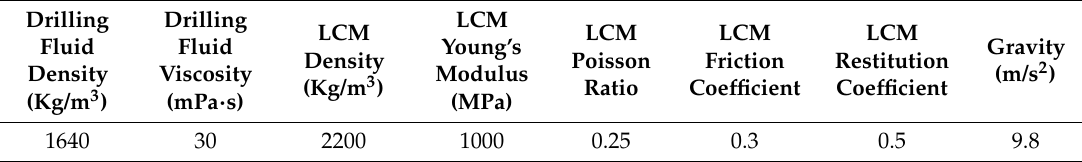
Table 1. Property parameters in the numerical